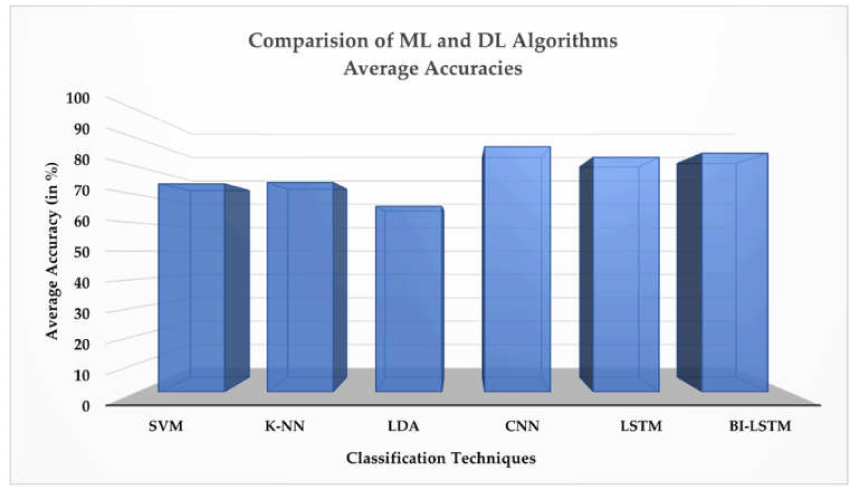
Figure 11. Comparison between machine-learning (ML) classifiers (support vector machine (SVM), k-nearest neighbor (k-NN), and linear discriminant analysis (LDA)) and deep-learning (DL) classifiers (convolutional neural network (CNN), long short-term memory (LSTM), and bidirectional LSTM (Bi-LSTM)) based on average